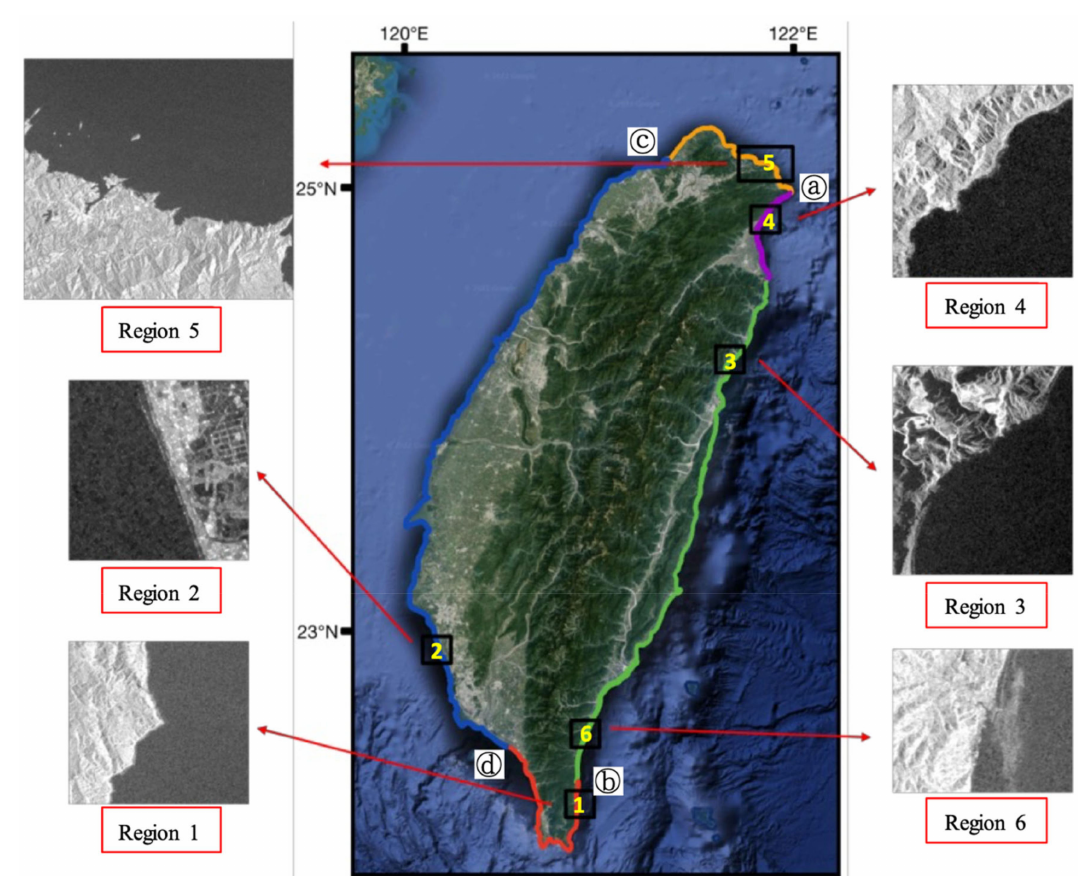
Figure 6. Six regions selected from the study